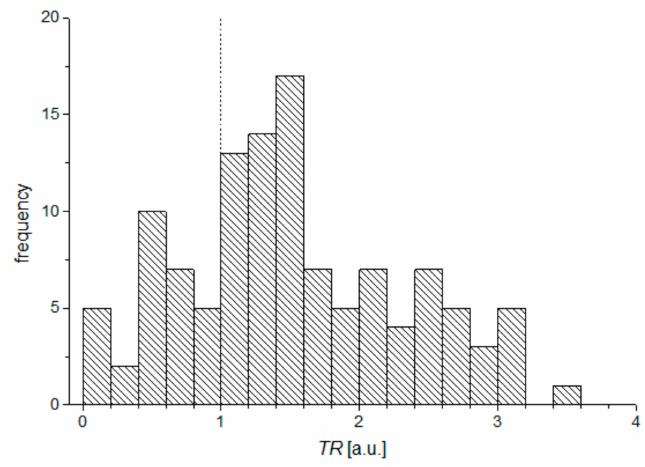
Figure 7. Histogram of TR parameters for all